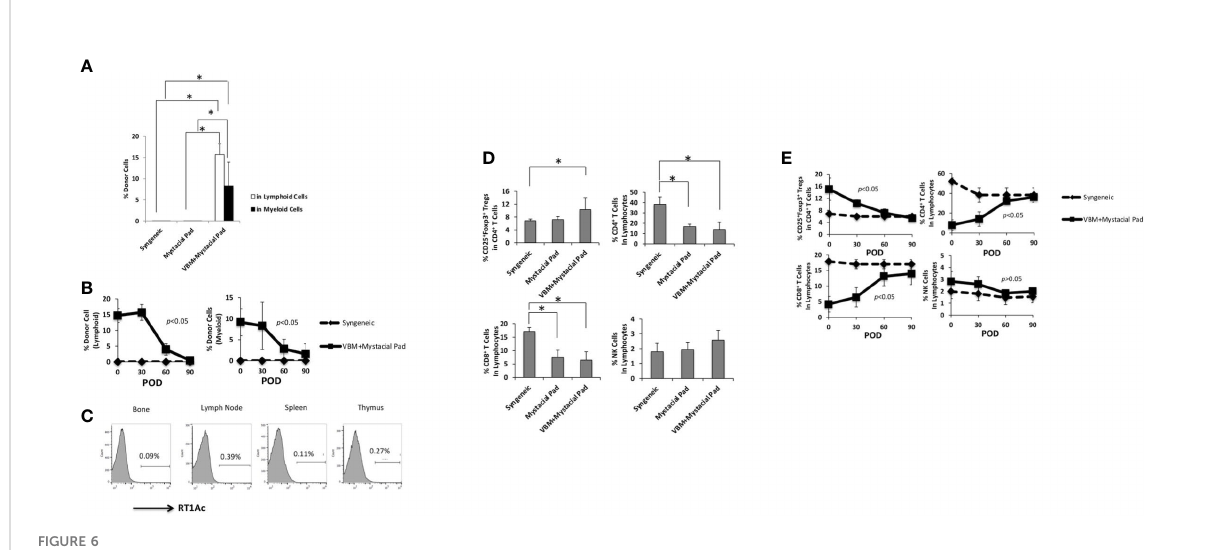
FIGURE 6 Vascularized bone marrow transplant promotes tolerance with transient peripheral multilineage chimerism. (A) Percentage of donor cells circulating in the recipient on 30 days post mystacial pad transplantation and (B) at multiple time points during observation post mystacial pad transplantation. (C) Chimerism was barely detected in multi-lymphoid organs in long-term tolerant animals (90 days post mystacial pad transplantation). (D) Peripheral blood analysis of recipients among different groups on 30 days post mystacial pad transplantation. (E) Peripheral blood analysis of recipients among different groups at multiple time points during observation. The asterisk denotes statistical signi fi cance ( p <